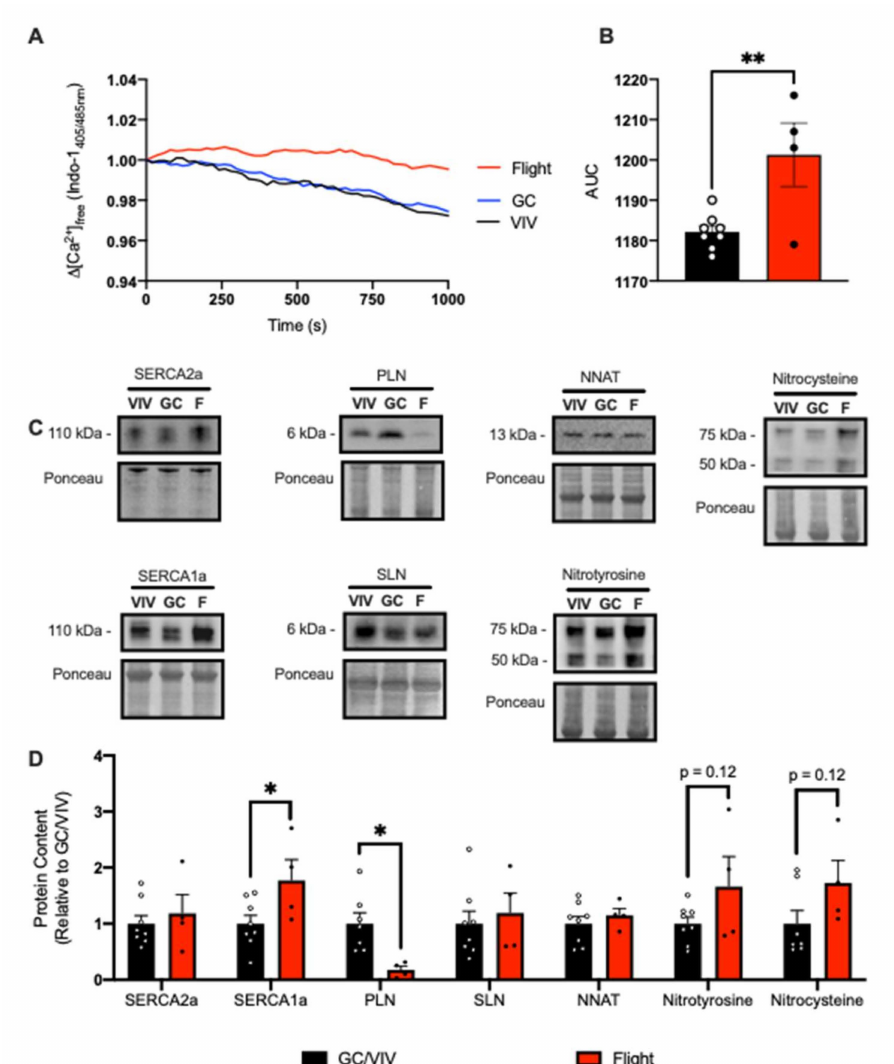
Figure 2. Spaceflight reduced Ca 2+ uptake in the soleus from female mice. ( A ) Change in the ratio of Ca 2+ -bound to Ca 2+ -free Indo-1 (405/485 nm emission). ( B ) AUC was significantly increased in the flight group compared with GC/VIV representing reduced Ca 2+ uptake. Representative Western blot images ( C ) and densitometric analysis ( D ) of SERCA2a/1a, PLN, SLN, NNAT, and total protein T-nitration and S-nitrosylation. All values are means ± SEM, and Western blot data are presented relative to GC/VIV control. * p < 0.05; ** p < 0.01 and values above bars indicate p -values using Student’s t -test ( n = 4–8 per